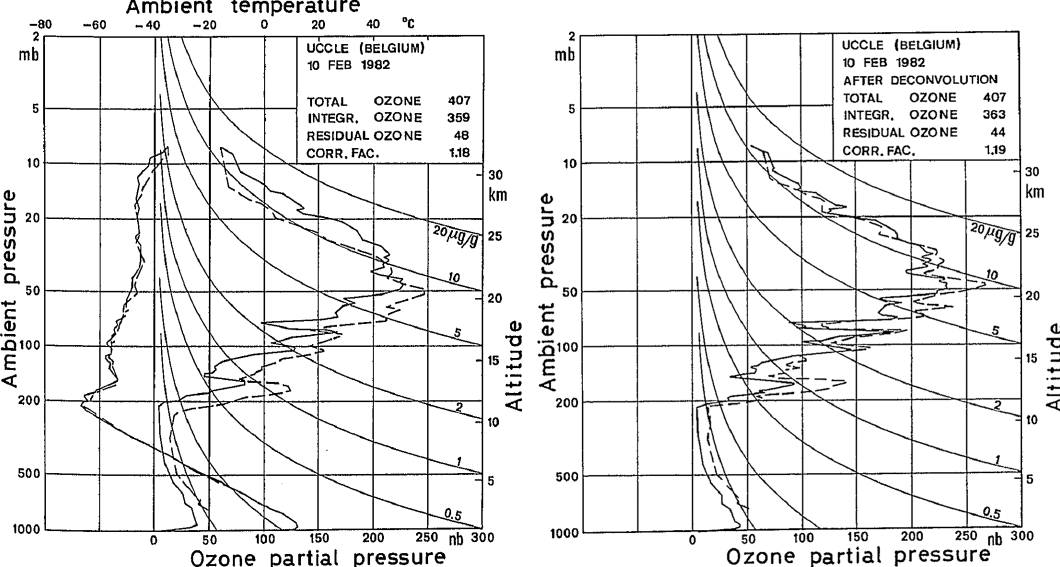
Figure 1. Ozone sounding at Uccle on 10 February 1982 with a Brewer-Mast ozonesonde before (left) and after (right) deconvolution of the ozone profile for both ascent (solid line) and descent (dashed line) of the sonde. In the left panel, the vertical profile of the air temperature is also shown (figure taken from De Muer and Malcorps,